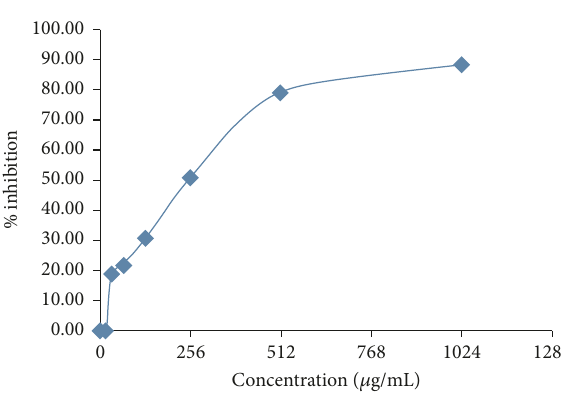
Figure 2: Inhibitory activity of mango twigs extracts against S. mutans .